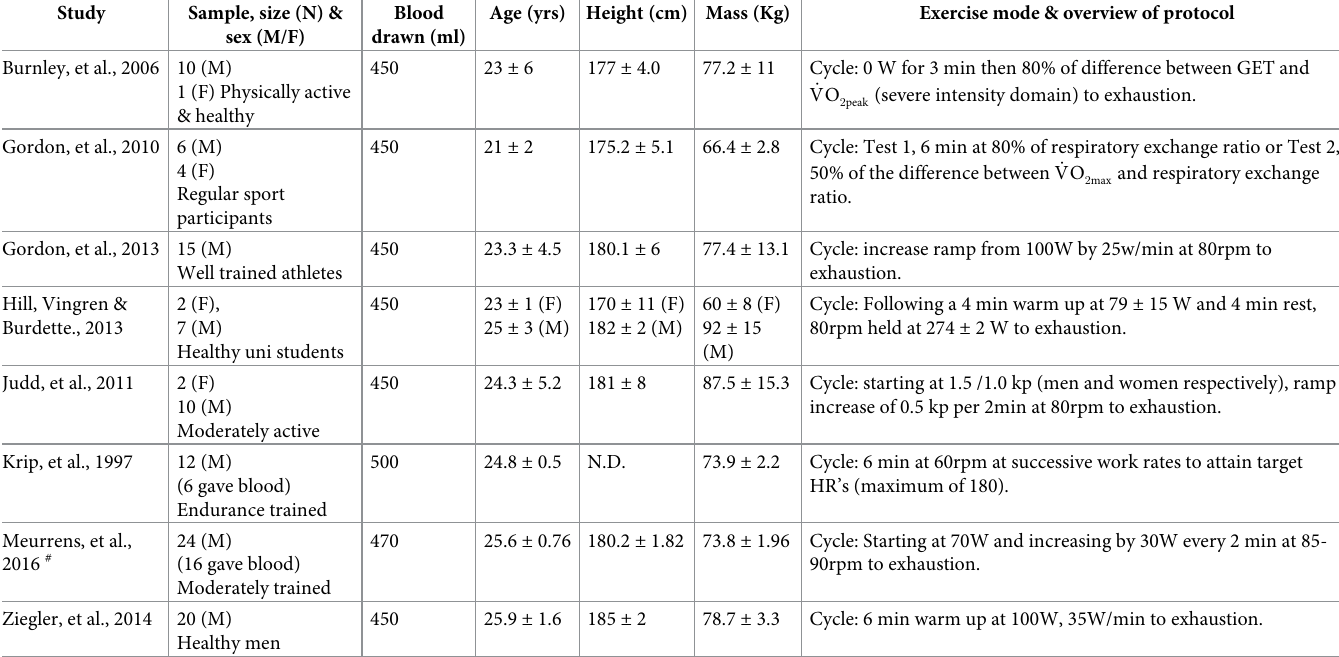
Table 1. Overview of the 9 studies included. Sample size varied, as did the combination of male (M) and female (F) participants. Blood donation volumes ranged from 450–500 ml. With age, height and mass reported as mean ± SD. Study Sample, size (N) & sex